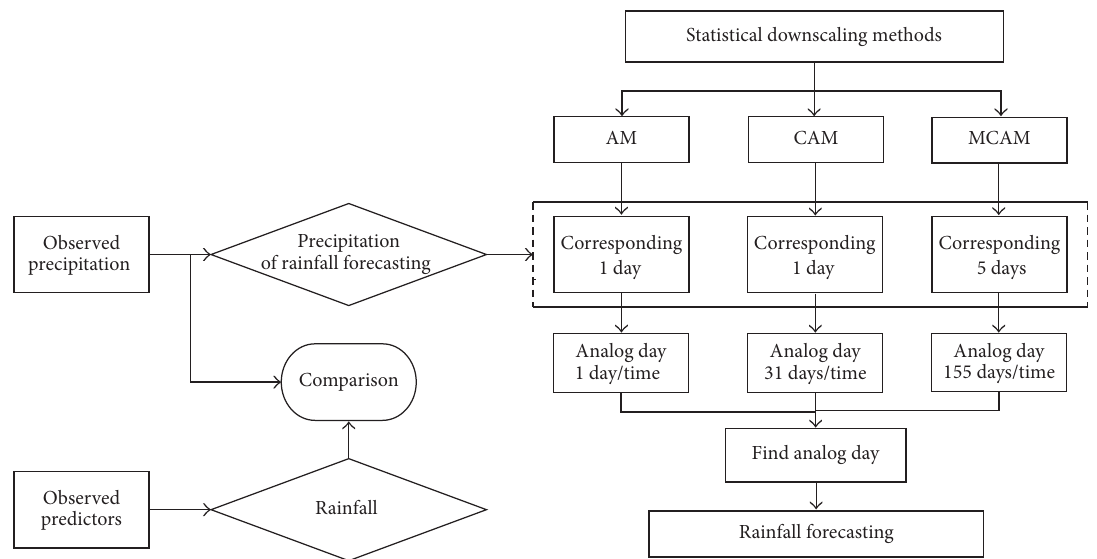
Figure 3: The process for the AM, CAM, and MCAM in this study.